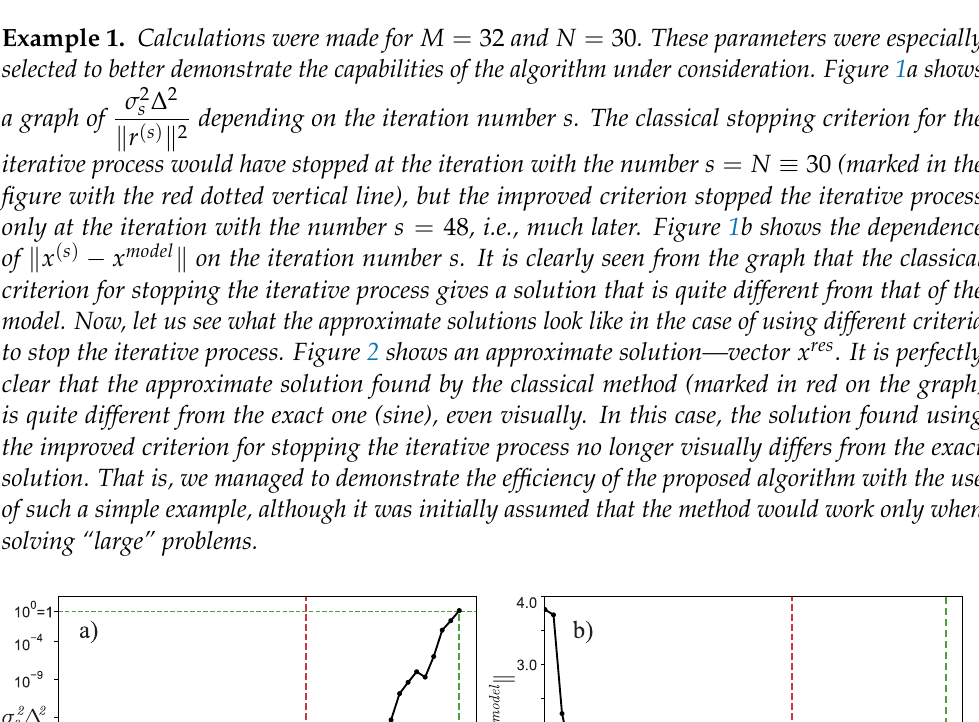
σ 2 s ∆ 2 depending on the iteration number s . ( b ) Graph of (cid:107) r ( s ) (cid:107) 2